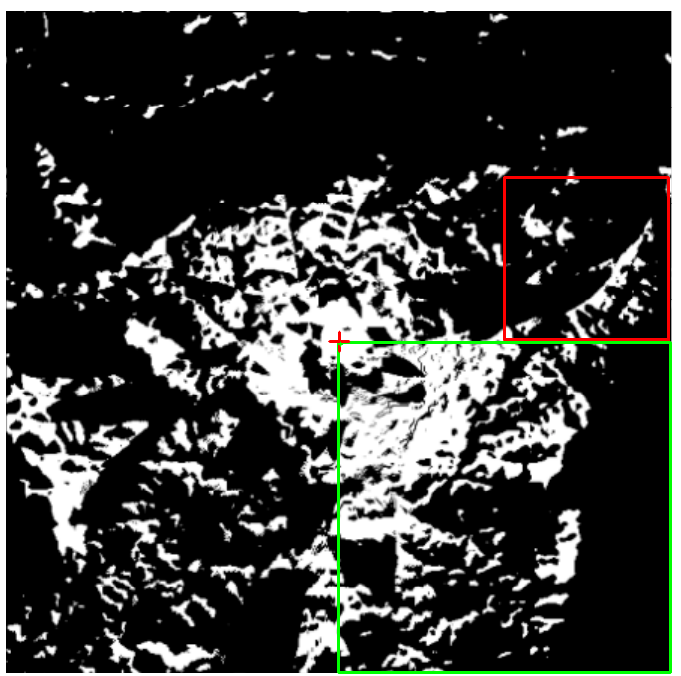
Figure 9. Viewshed generated by R3 with a viewpoint located at the center. The radius of the analysis area is 300 and the observer is 30 meters above the ground.